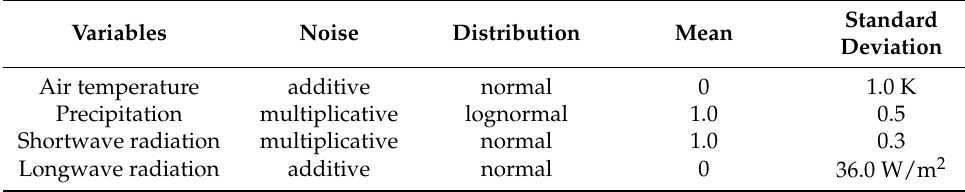
Table 2. Perturbations in the atmospheric forcing data used in this study.